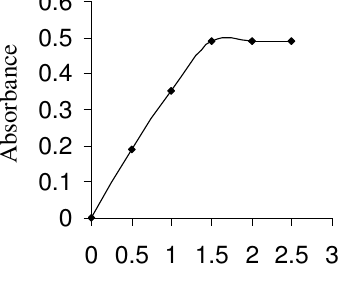
Figure 3. Effect of F-C reagent concentration (90 µ g mL -1 drug + 1.5 mL of sodium